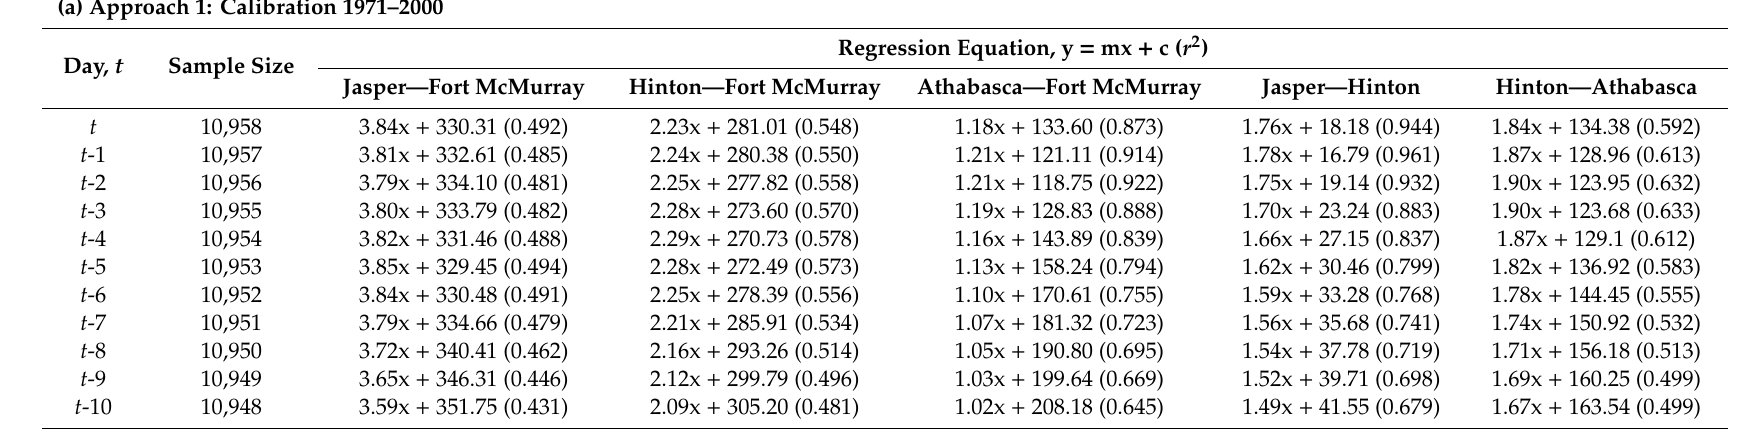
Table 3. Summary of correlation parameters estimated for various station pairs to determine the optimal lead time using: ( a ) Approach 1, and ( b ) Approach 2. (a) Approach 1: Calibration